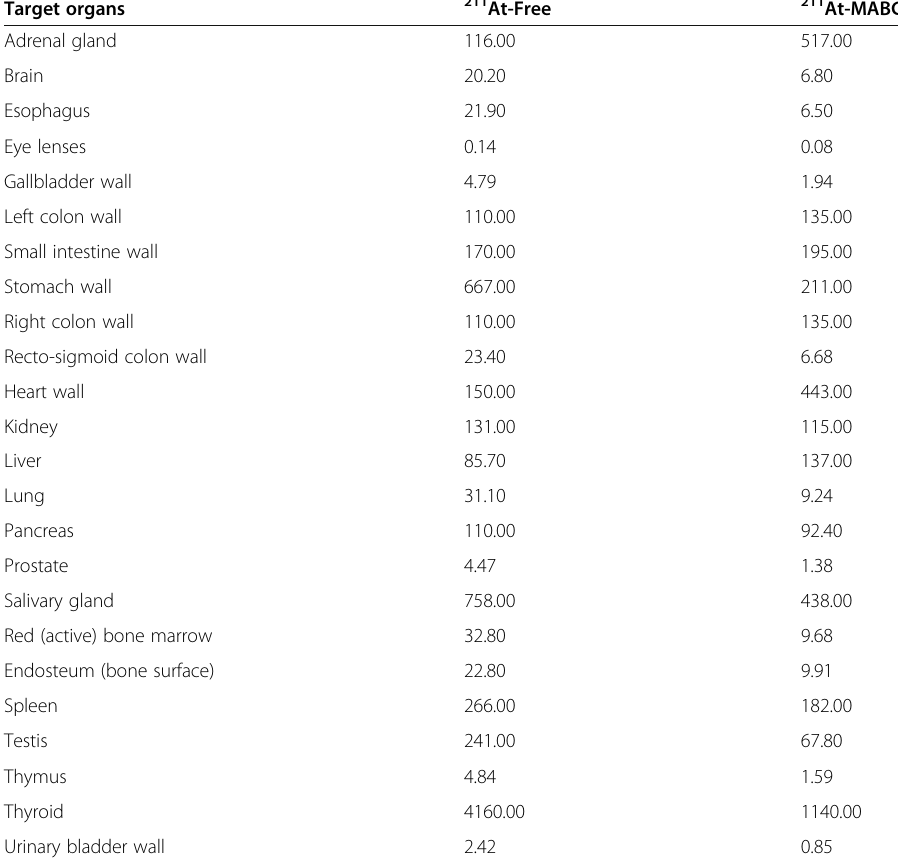
Table 6 Radiation dosimetry estimates per unit administered activity [ μ Gy/MBq] from IDAC-dose 2.1 for free 211 At and 211 At-MABG for human adult male phantom. It was calculated by extrapolation from the distribution data of mice Target